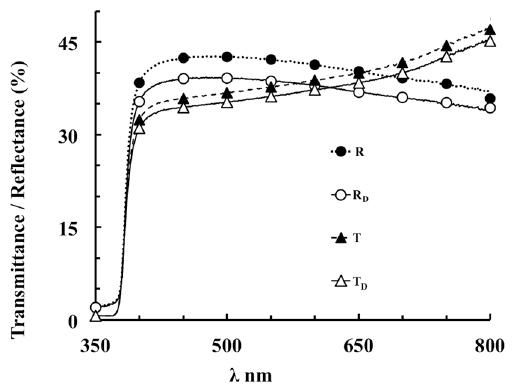
, T ) components of D D